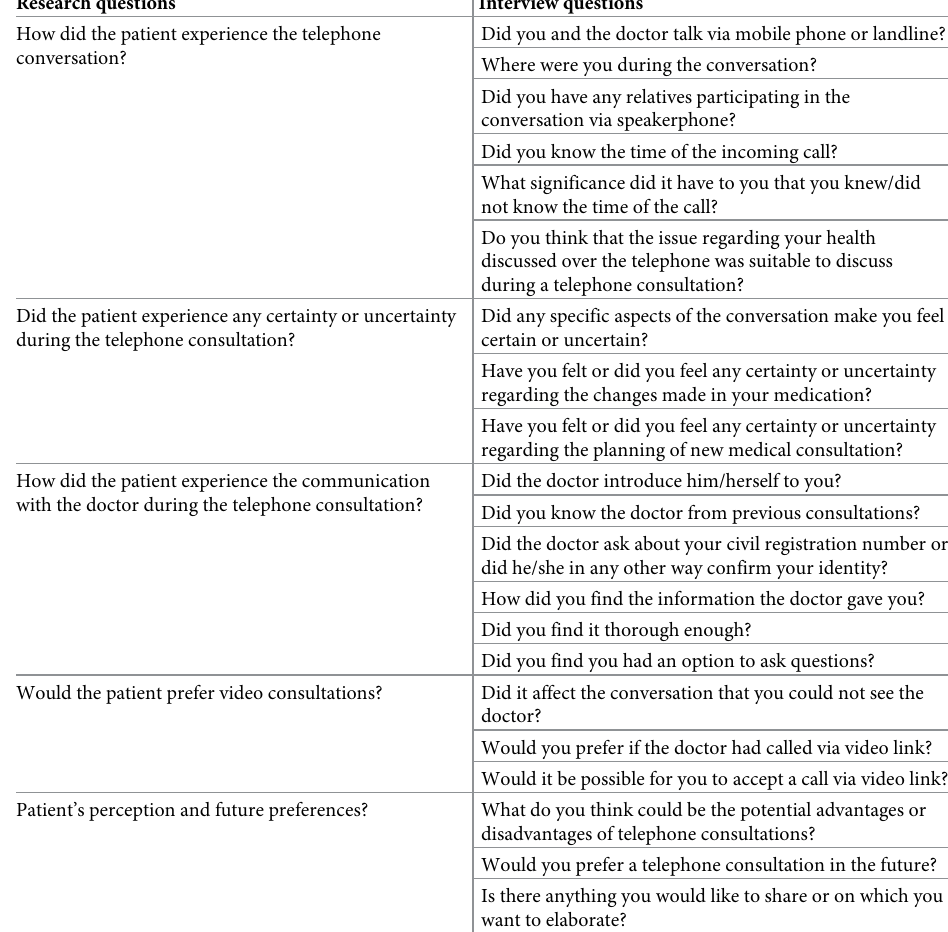
Table 1. Semi-structured interview